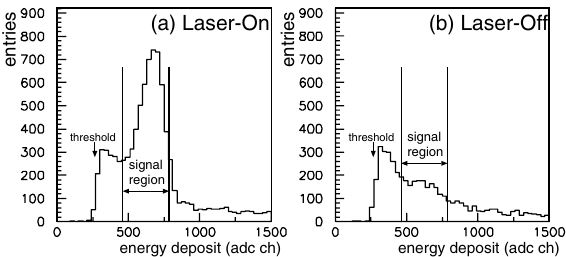
FIG. 4. Energy spectra measured by the CsI detector. (a) The laser ‘‘on’’ state; (b) ‘‘off’’